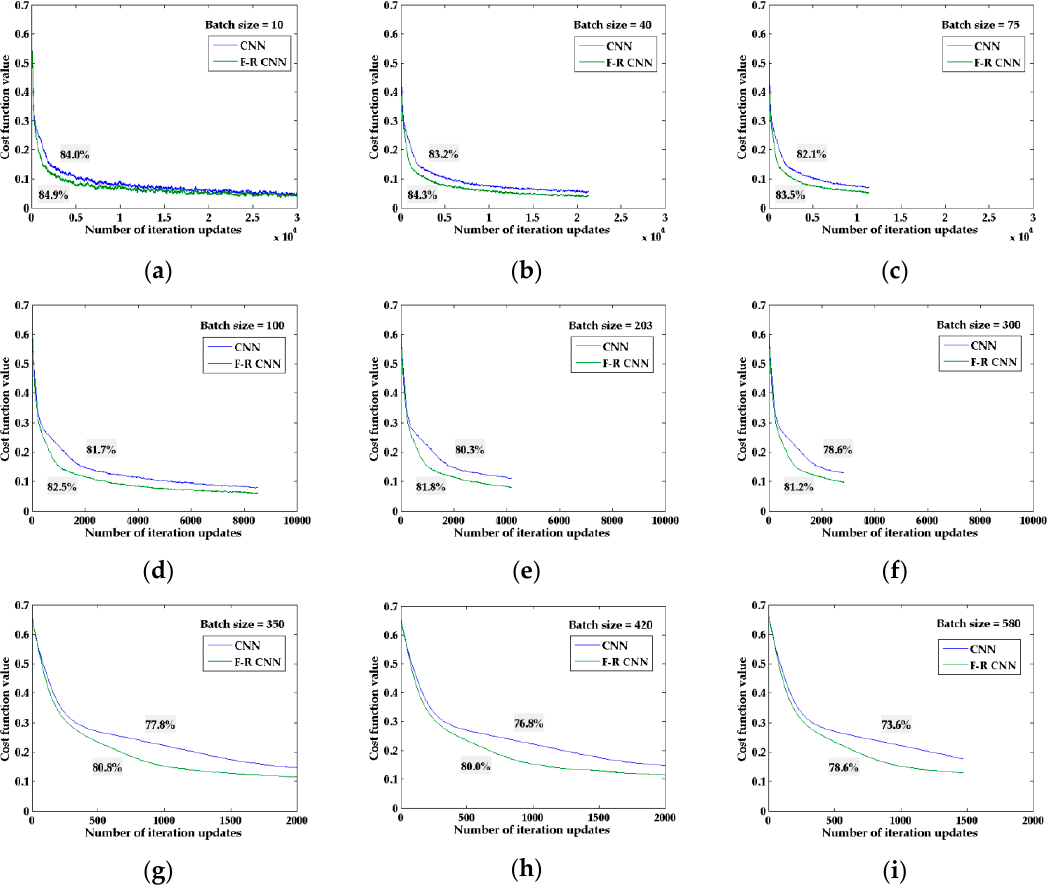
Figure 10. Cost function convergence curves. ( a ) ~ ( i ) Batch training sizes are 10, 40, 75, 100, 203, 300, 350, 420, and 580 respectively. The classification accuracy of the two models is marked at the corresponding convergence curve.